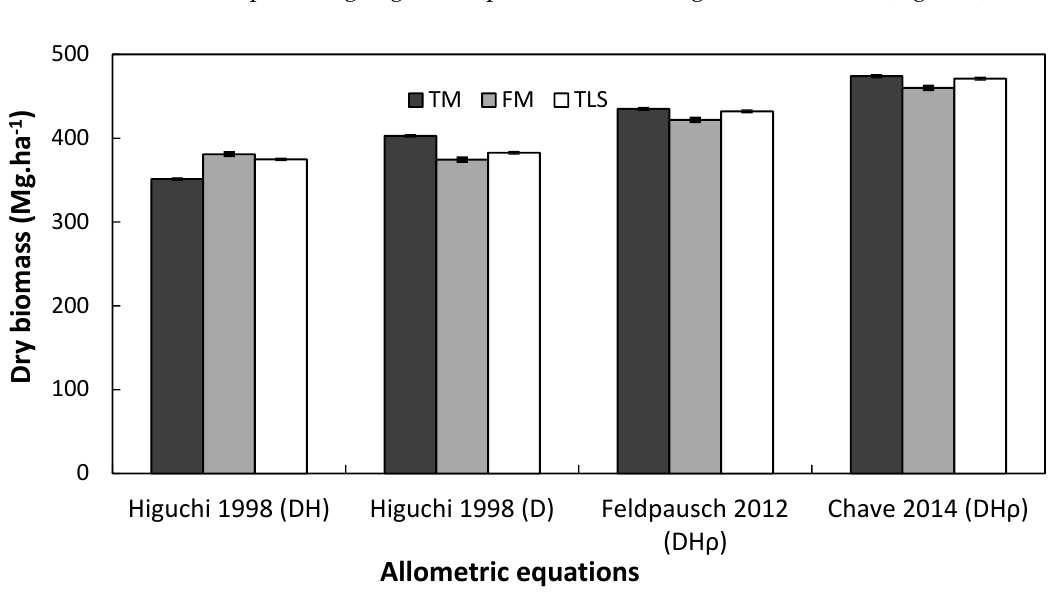
Figure 8. A bar chart showing the estimates of aboveground biomass based on different methods—tape measurement (TM), Field-Map bundle (FM), Terrestrial LiDAR (TLS)—to calculate the estimates of aboveground biomass (using DBH RHT and TLS Height ) and based on different allometric equations (listed in Table A1) and assessing the vegetation parameters such as diameter (D in cm), height (H in m) and wood density ( ρ in g cm − 3 ).